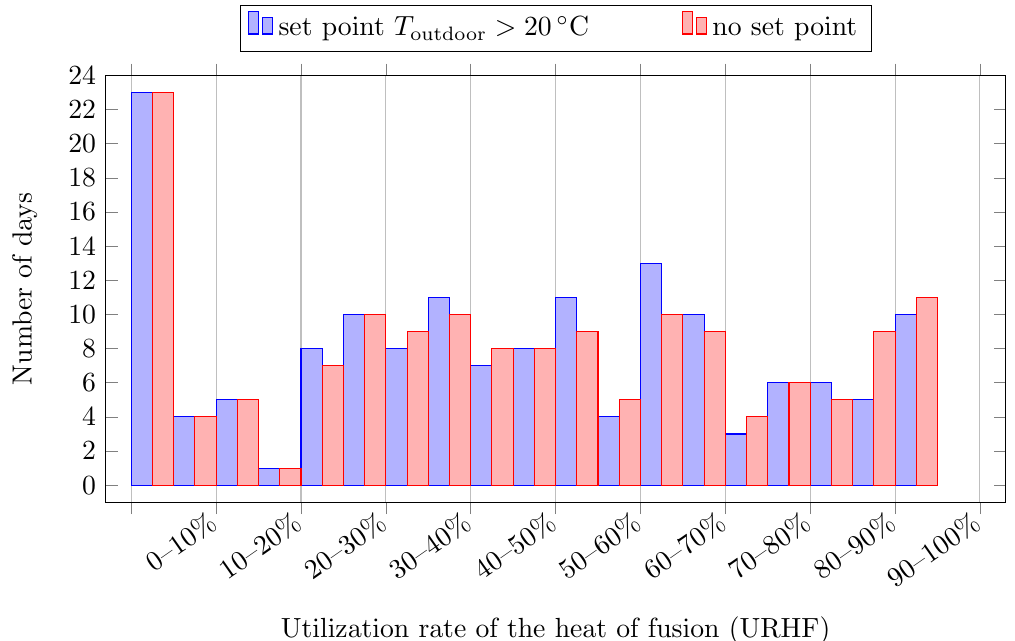
Figure 9. Histogram of the utilization rate of the heat of fusion (URHF) for Madrid and the nominal phase change temperature T mpc = 24 ◦ C; each bar represents a range of